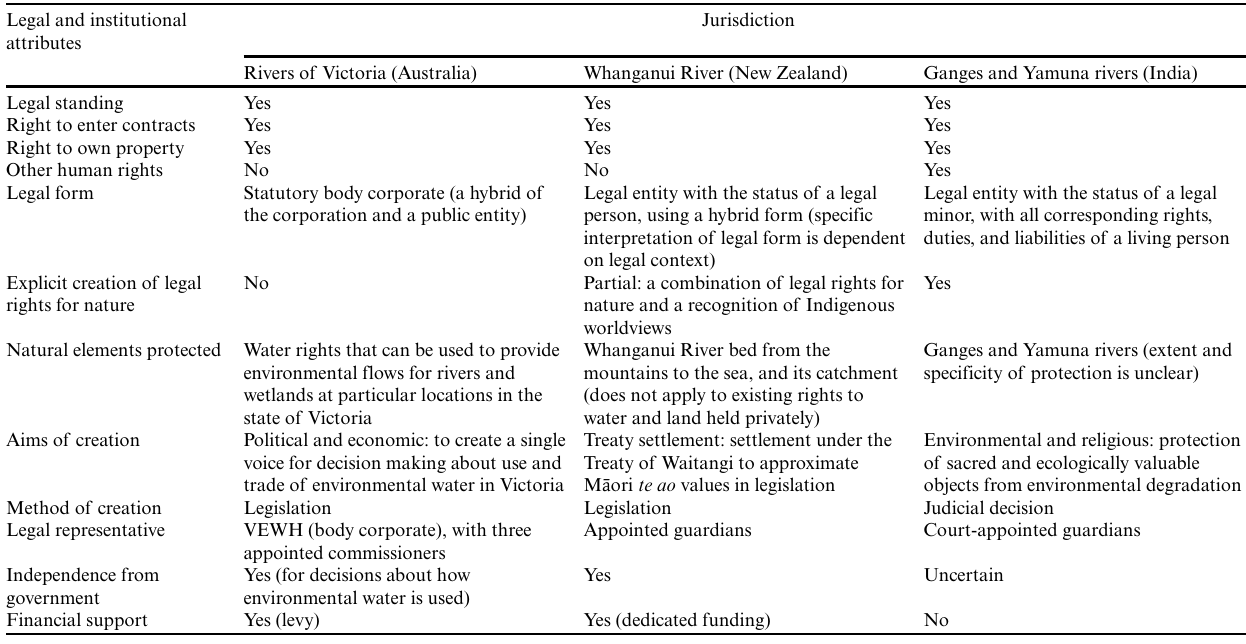
Table 1 . Creating legal rights for rivers in Australia, New Zealand, and